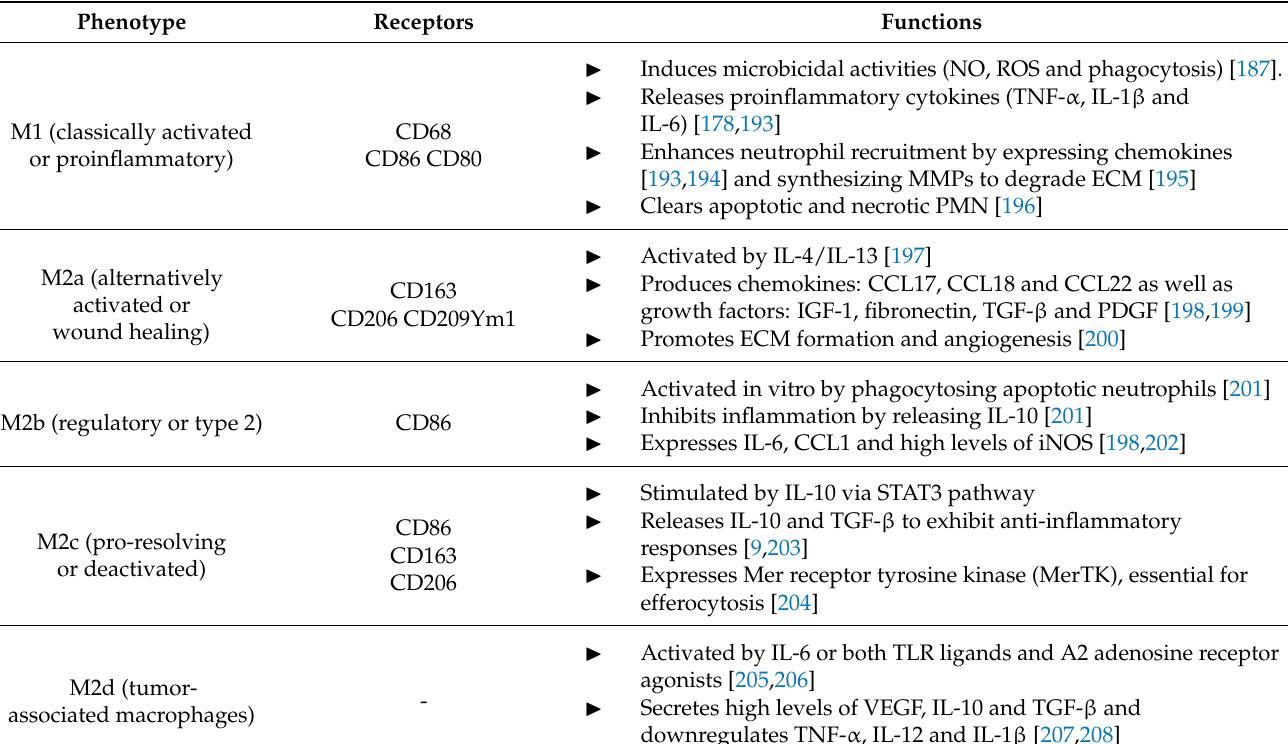
Table 2. Functions of macrophage phenotypes during tissue